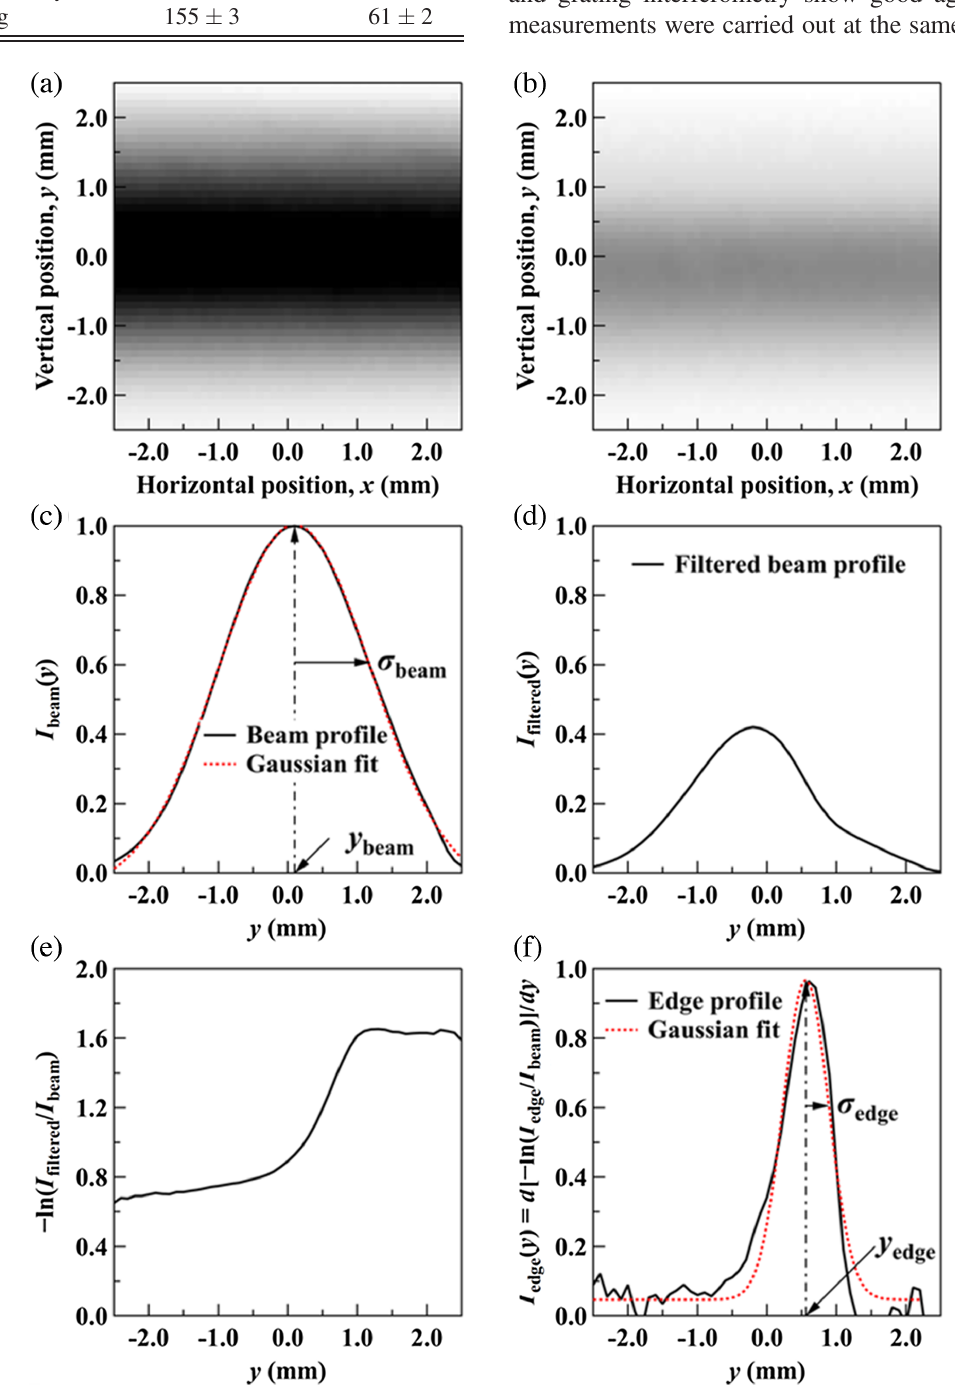
FIG. 6. Images of the beam (a) without the K-edge filter (beam side) and (b) with the K-edge filter (edge side). (c) Horizontally ð y Þ , and a Gaussian fit. (d) Horizontally averaged filtered beam profile, I averaged beam profile, I beam =I logarithm of the normalized I profile, and (f) its derivative with Gaussian filtered beam